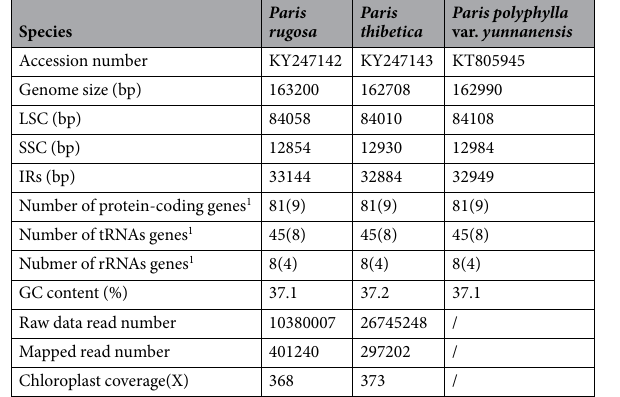
Table 1. Comparison of feature of Paris rugose , Paris thibetica , Paris polyphylla var. yunnanensis . 1 The numbers in parenthesis indicate the genes duplicated in the IR regions.